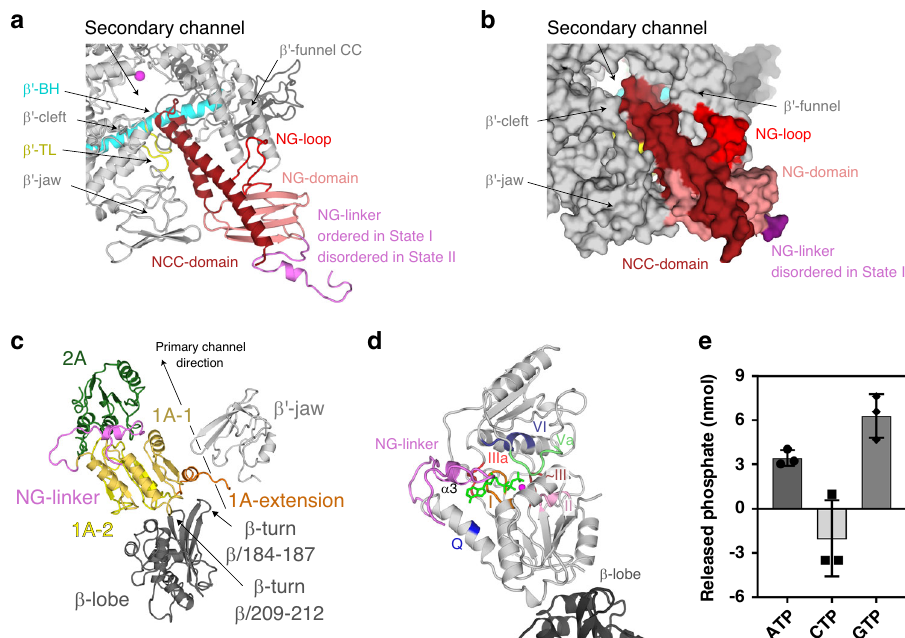
Fig. 2 The HelD N-terminal domain inserts into the RNAP secondary channel; domains 1A – 2A comprise the NTPase unit. a , b Ribbon (State I) and surface (State II) representation of the HelD N-terminal domain interaction with the secondary channel of RNAP core (gray). The HelD coiled-coil domain (NCC-domain, fi rebrick) and the distinct loop (NG-loop, red) of the HelD globular domain (NG-domain, salmon) are inserted between β ′ -funnel, shelf, and jaw. The NCC-domain reaches only the boundary line of the β ′ bridge helix ( β ′ -BH, cyan) and leaves a passageway to the RNAP core active site (MgA, magenta sphere). The HelD NCC also restricts the trigger loop (TL, yellow) movement. The linker (NG-linker, violet) connects the N-terminal domain with domain 1A-1. c The two Msm HelD Rossman fold domains (1A yellow and 2A green) form a canonical NTPase unit heterodimer with respect to structurally described SF1 helicases. Domain 1A tightly packs with β -lobe (dark gray) and its extension (brown) is clamped in between one β -turn ( β /184 – 187) of β -lobe and the tip of the β ′ subunit jaw (light gray). d Model of ATP binding to the conserved nucleotide-binding site of motifs Q (blue), I (brown), II (pink), ~III (orange), IIIa (red), Va (pale green), and VI (deep blue). ATP (green) and Mg 2 + (magenta sphere) are added based on superposition with the ternary complex of UvrD (PDB ID 2IS4). e HelD exhibits ATPase and GTPase activities but does not hydrolyze CTP. The apparent negative value of CTP hydrolysis was caused by high background readings. The bars show mean values, the error bars indicate ±SD and the individual symbols represent values from three independent replicates. The data were analyzed and the graphics created with GraphPad Prism